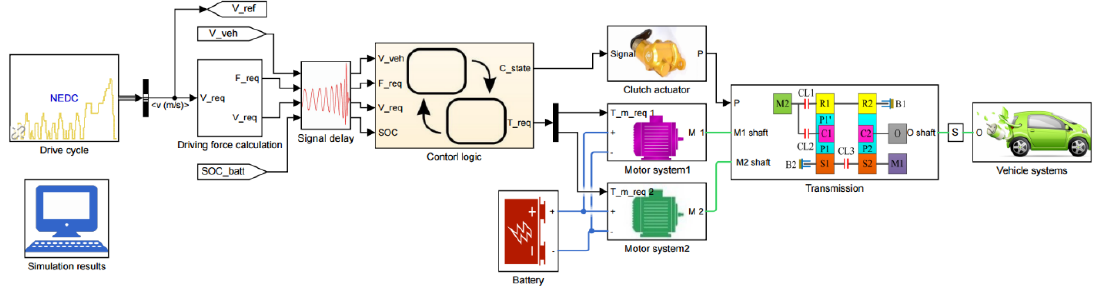
Figure 11. The simulation structure.